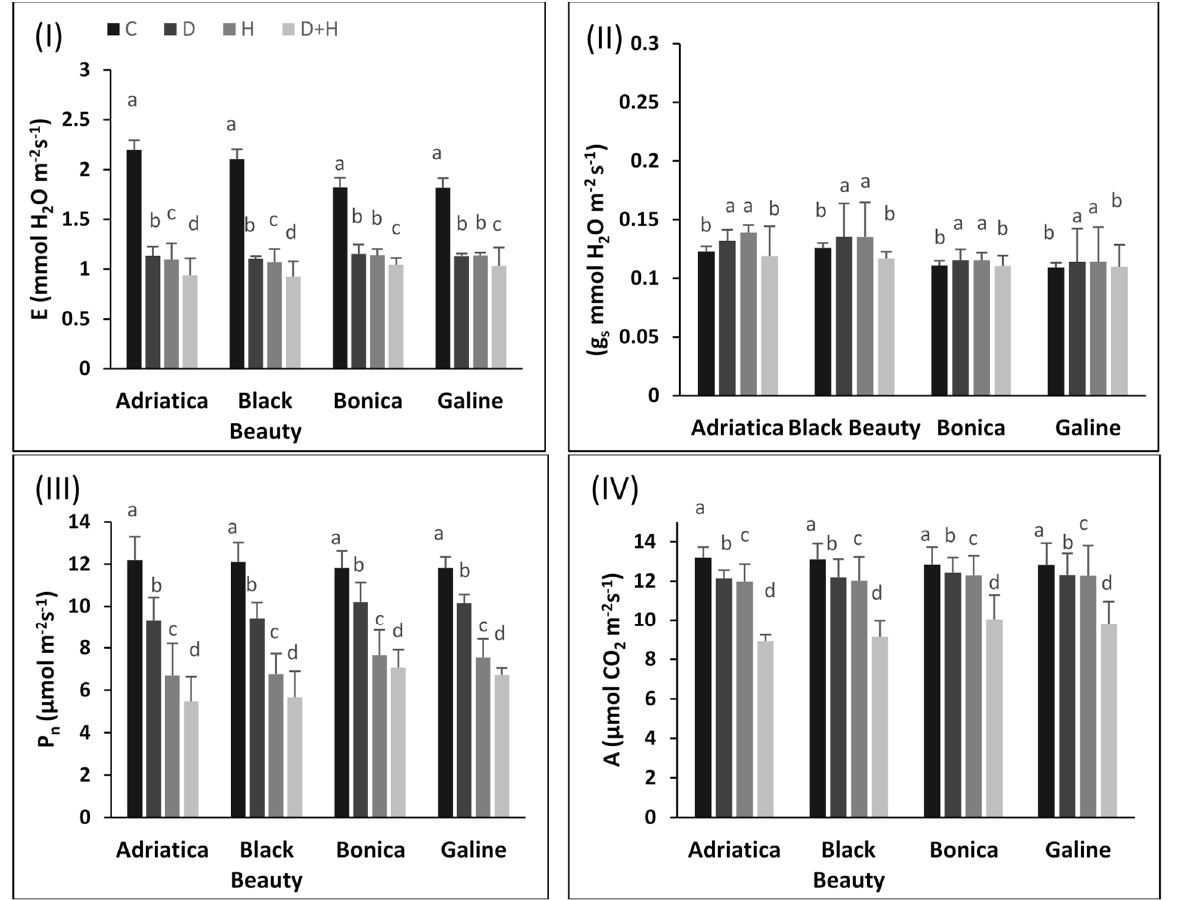
Figure 2. Changes in photosynthesis and gas exchange parameters under individual and combined stresses. ( I ) Transpiration rate (E), ( II ) stomatal conductance (gs), ( III ) net photosynthesis (Pn), and ( IV ) CO 2 assimilation rate (A) in four eggplant varieties. Data presented are the means ± SE ( n = 5). Significant dissimilarities are shown by different lower-case letters between treatments ( p ≤ 0.05) based on Tukey’s test. (C, control; H, heat stress; D, drought stress; H + D, heat + drought stresses).